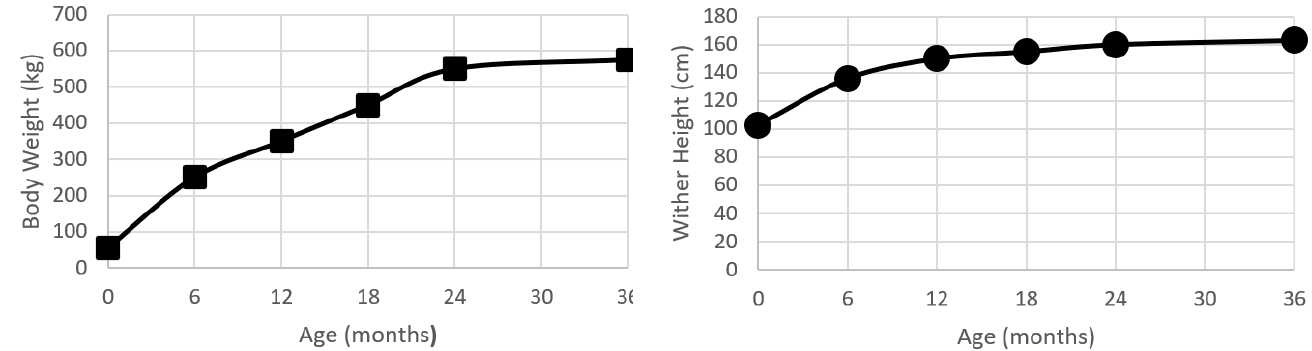
Figure 1. Plots of bodyweight (kg) and wither height (cm) from birth to 24 months age for a population of Kentucky Thoroughbreds. Data modified from Huntington, Brown-Douglas and Pagan [26].